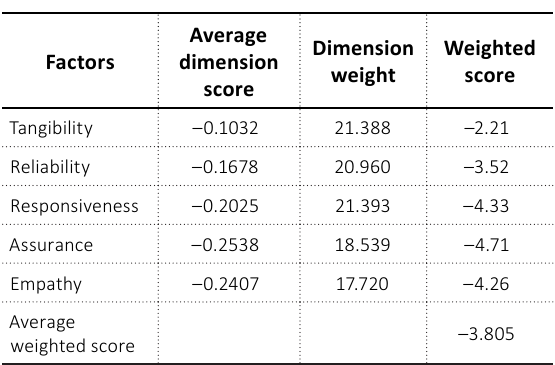
Table 8. Gap analysis between expectations and weighted